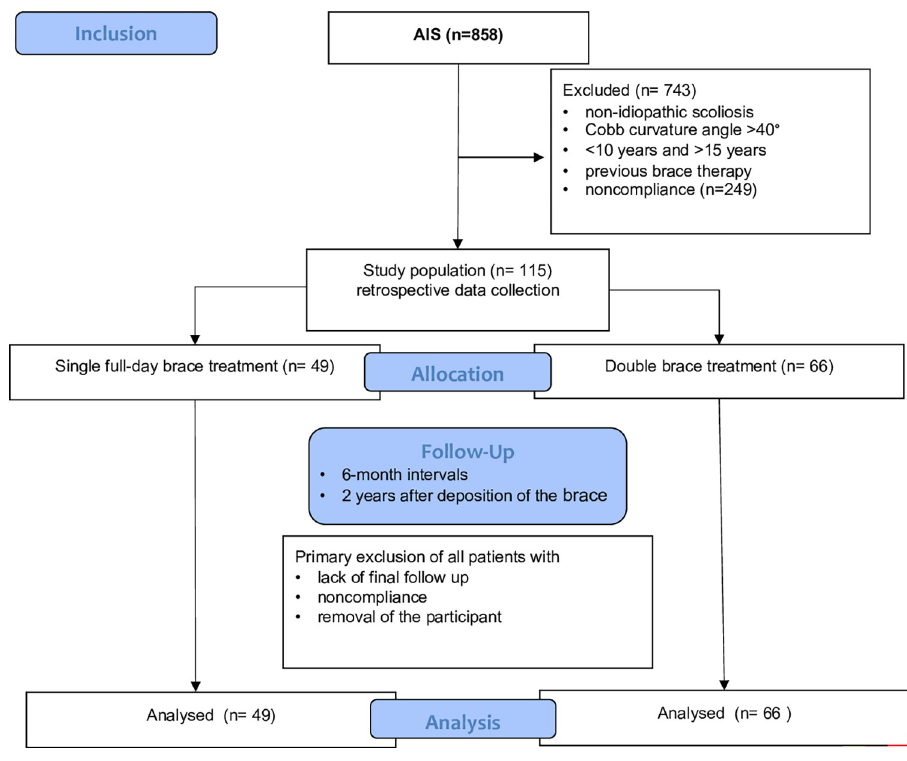
Fig 3. Flowchart of the study (CONSORT